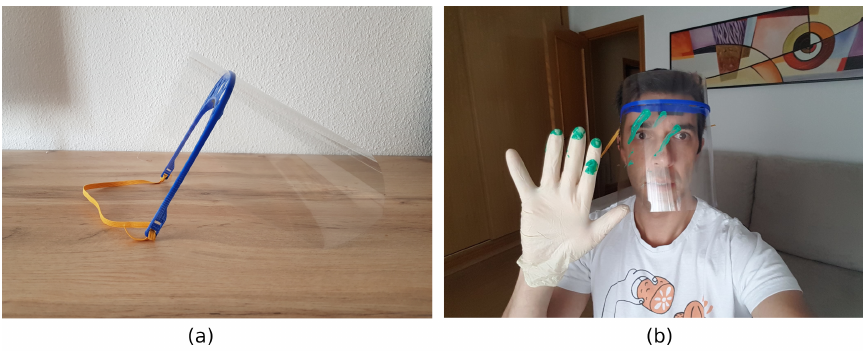
Figure 3. ( a ) Example of a face shield manufactured with 3D printing and ( b ) cross-contamination.